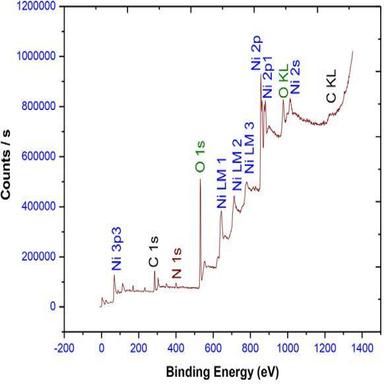
XPS full spectrum for Ch-PANI-NiO nanocomposite.